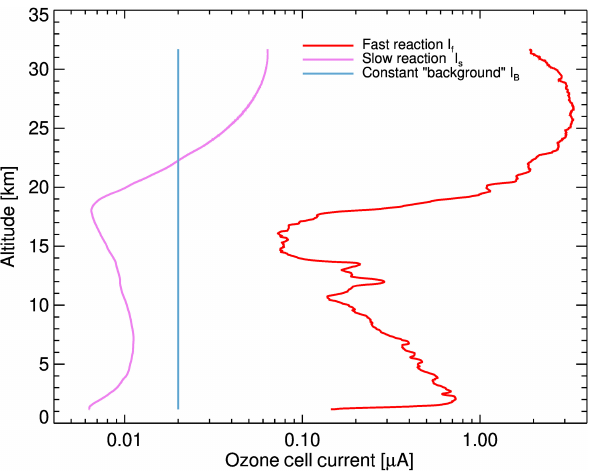
Figure 8. Contribution of the fast-reaction path (red) and the slow- reaction path (purple) to the measured cell current. The constant background used in the original processing is shown for